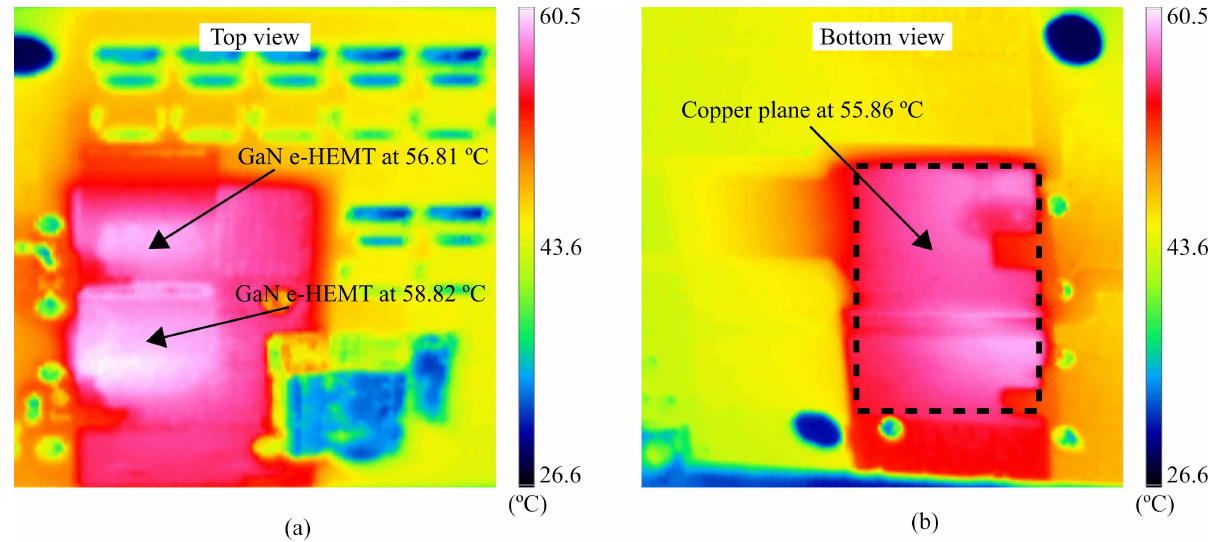
Figure 20. Thermogram of the bottom-side cooled converter without heatsink: ( a ) bottom view; and ( b ) top view.